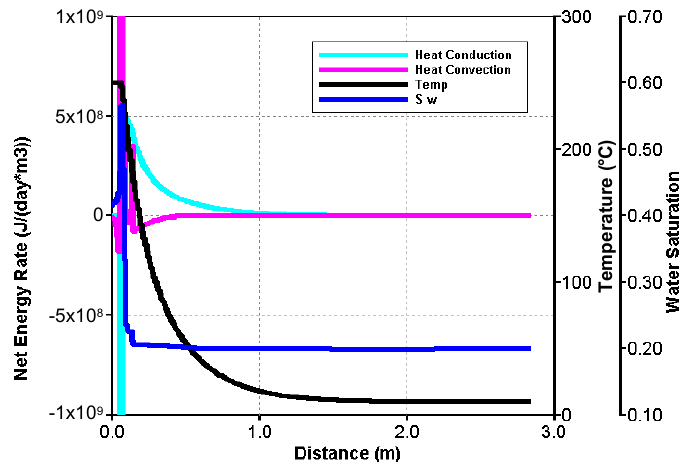
Figure 10. Conductive and convective heat transfer rates versus distance compared with temperature and water saturation profiles for the VE model.